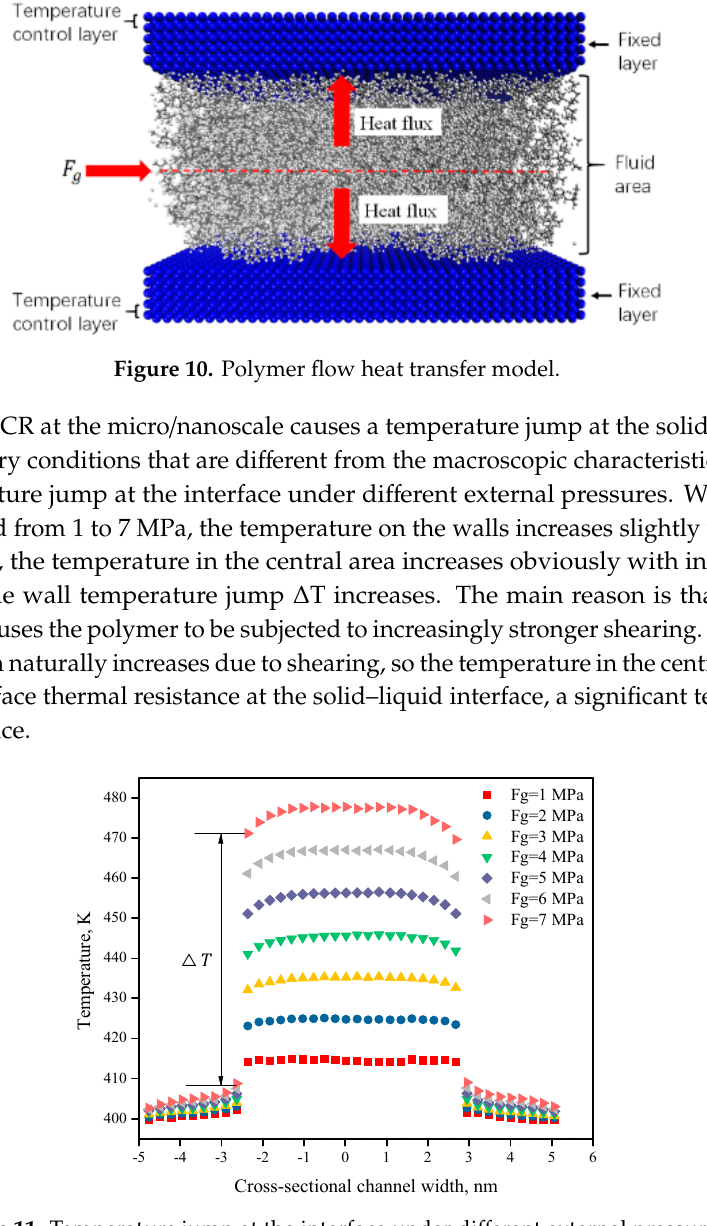
Figure 11. Temperature jump at the interface under different external pressures.